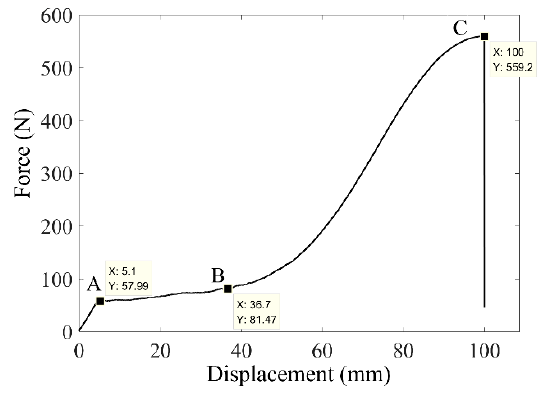
Figure 4. A load-displacement curve under tension test.